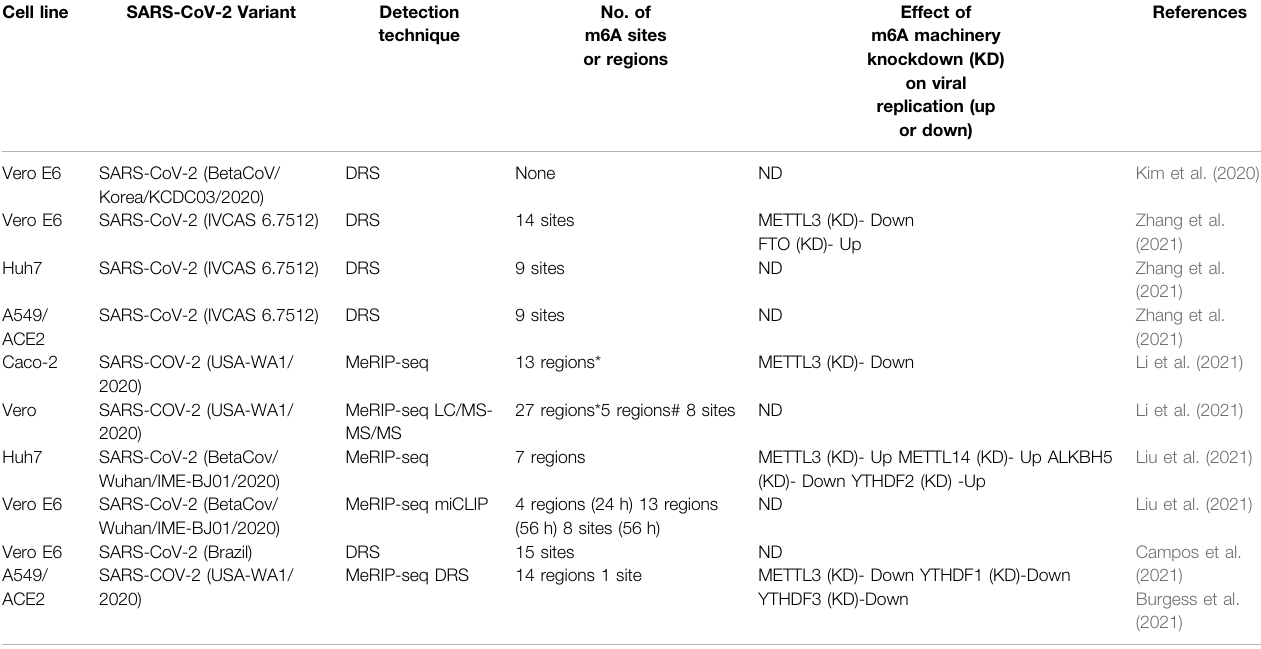
TABLE 1 | Summary of the studies on SARS-CoV-2 m6A modi fi cations. Cell